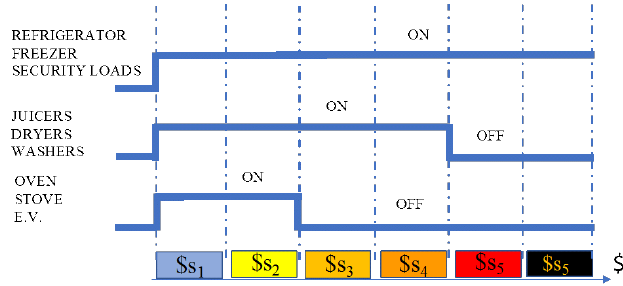
Figure 3. Operating loads cycles.